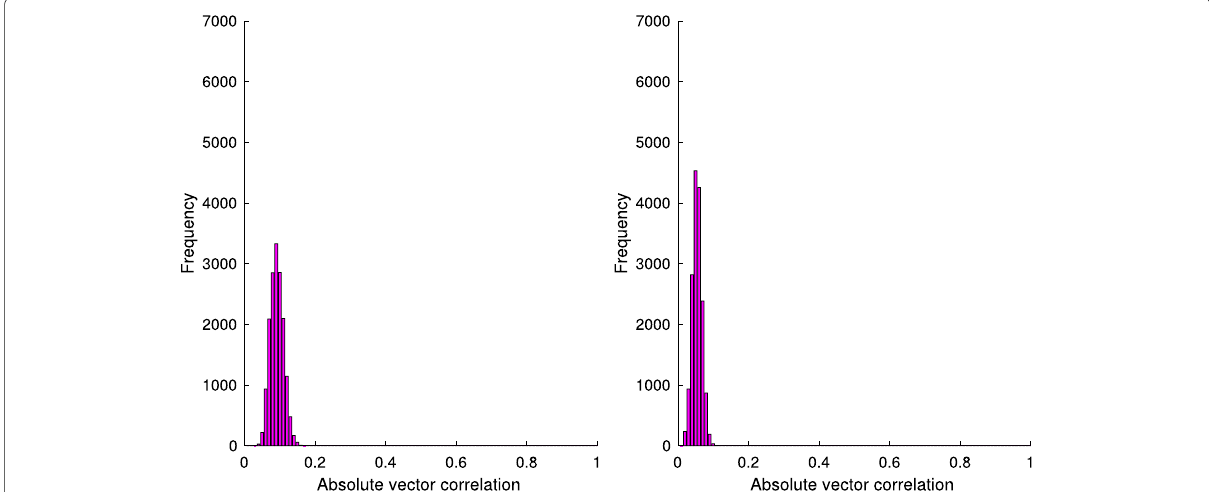
Fig. 3 Correlation distribution of frame vectors produced with Algorithm 4. Results are demonstrated for a 64 × 128 (left) and 96 × 128 (right) frame. Optimal lowest bound (Welch bound) is μ opt = 0.0887 and μ opt = 0.0512,